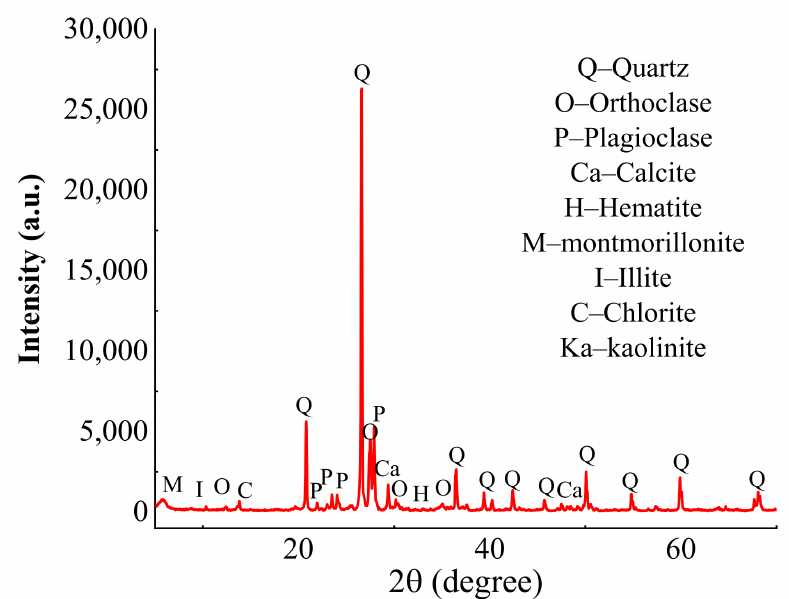
Figure 3. XRD diffraction patterns.